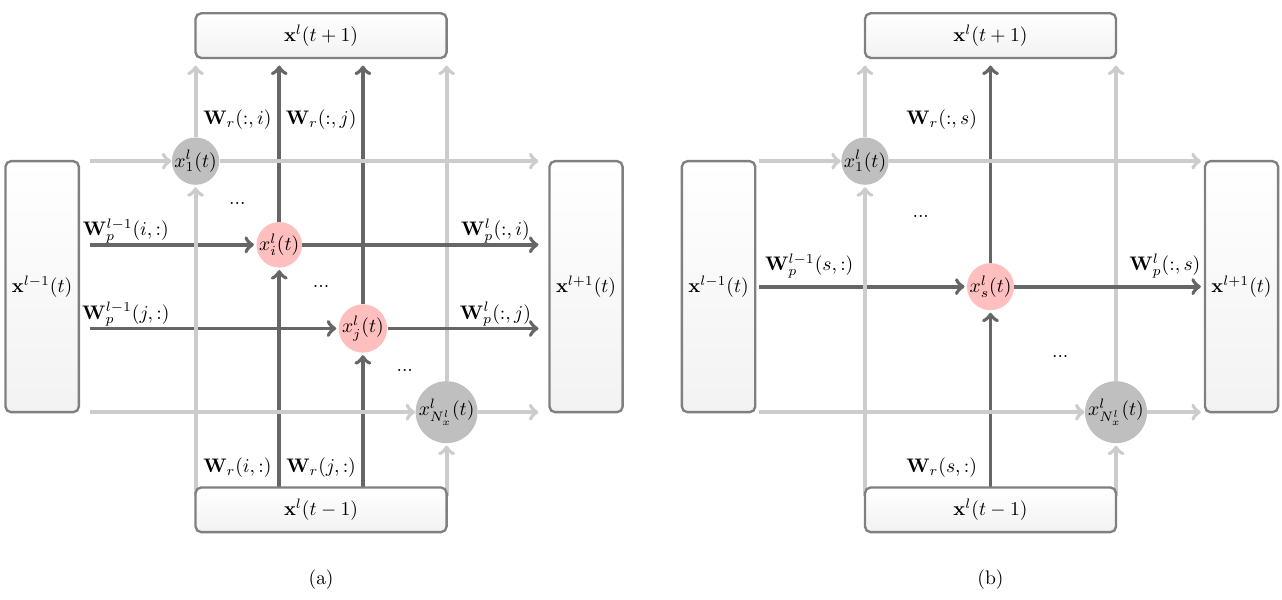
Figure 5. Weight coefficients diagram of connected neurons in reservoir ( l ) of DeepESN before ( a ) and after ( b ) merging a neuron by